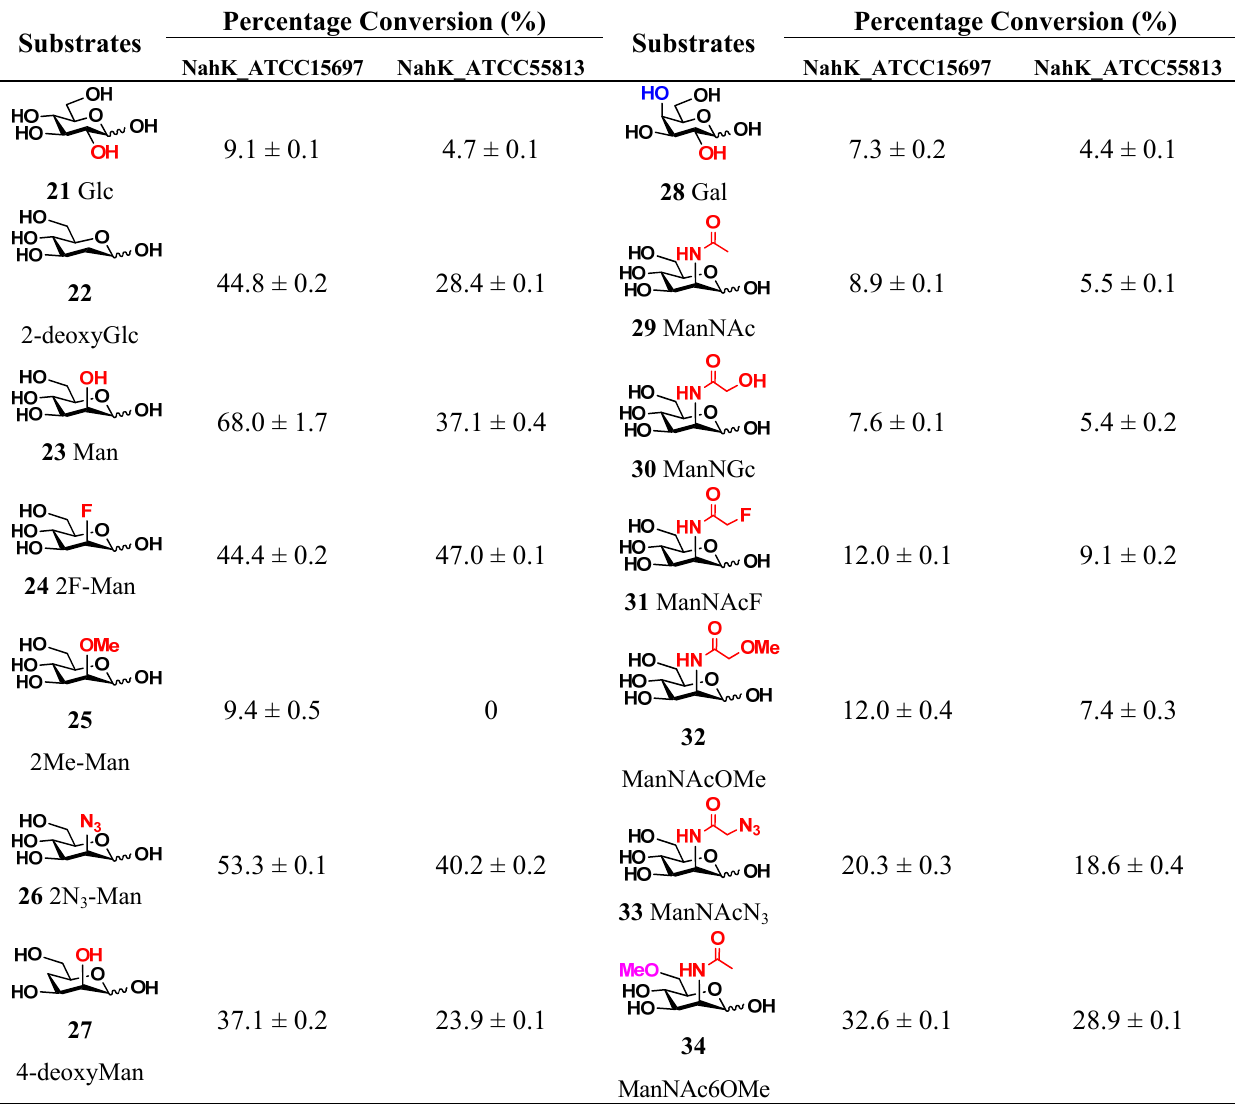
Table 3. Substrate specificity of NahKs using Glc, Gal, Man, ManNAc, and their derivatives.